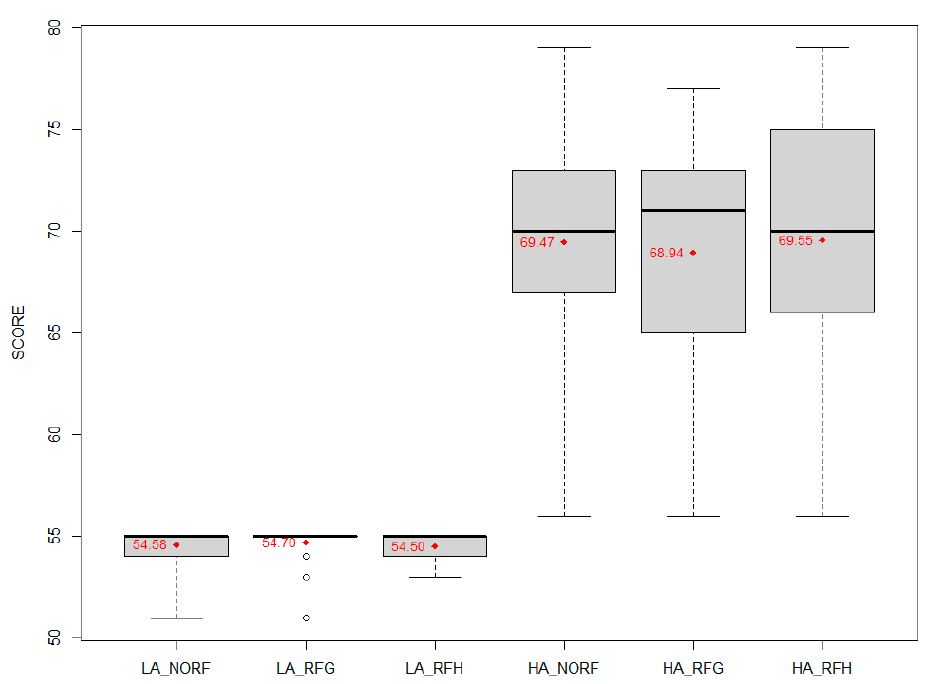
Figure 7. Boxplots of achieved scores for all conditions (with red circles marking and labeling the mean values of the scores).